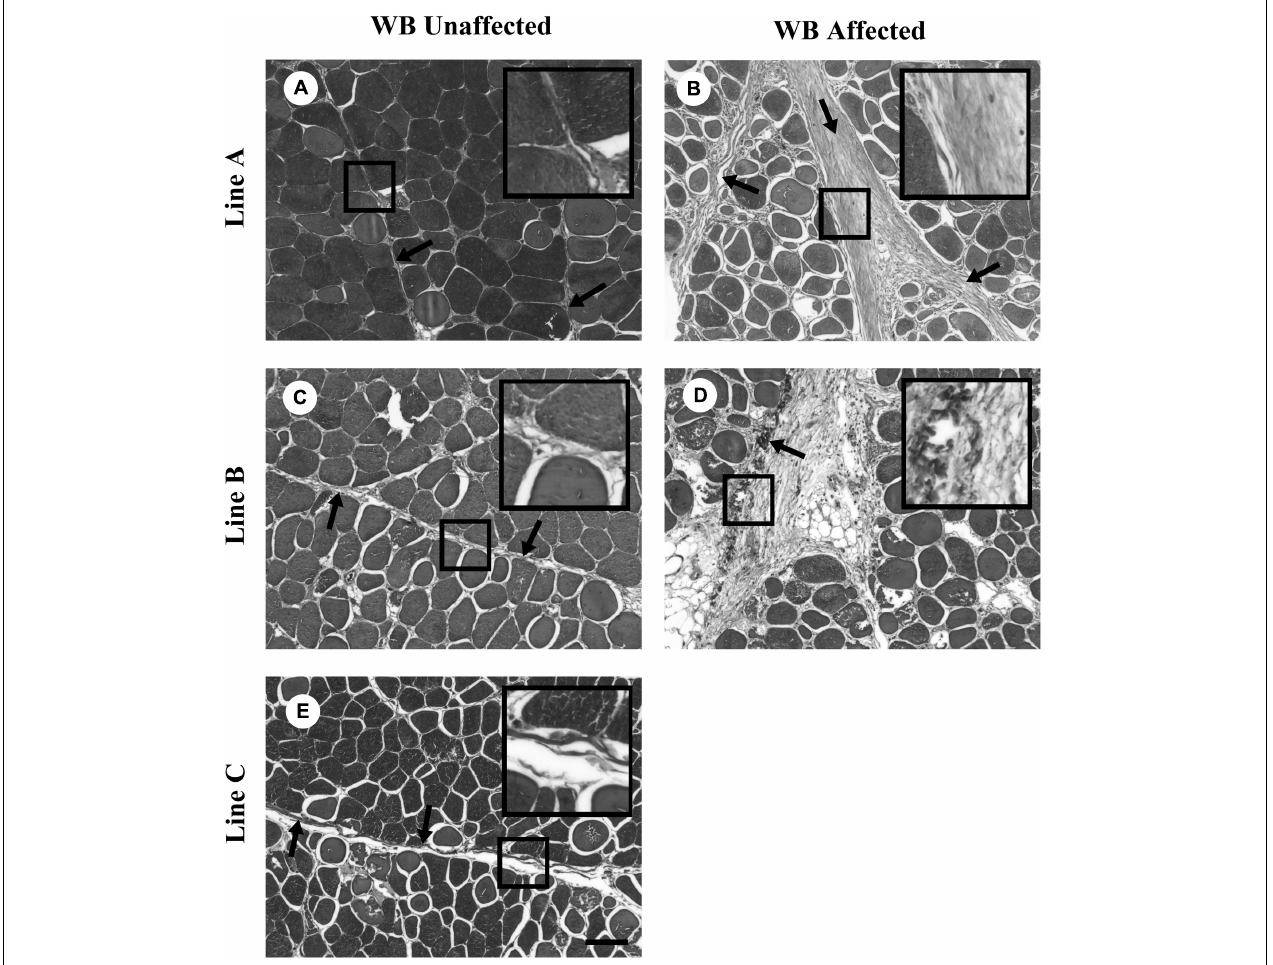
FIGURE 2 | Masson trichrome staining of collagen organization in wooden breast (WB)-unaffected and -affected pectoralis major muscle. (A,C,E) are representative images of WB-unaffected pectoralis major muscle from Lines A, B, and C, respectively. (B,D) are representative images of WB-affected pectoralis major muscle from Lines A and B, respectively. The arrows highlight fibrillar collagen and the boxes contain enlargements of the fibrillar collagen. Scale bar = 100 µ m. (Figure reproduced from Velleman et al., 2017. Avian Dis. 61, 481–490).